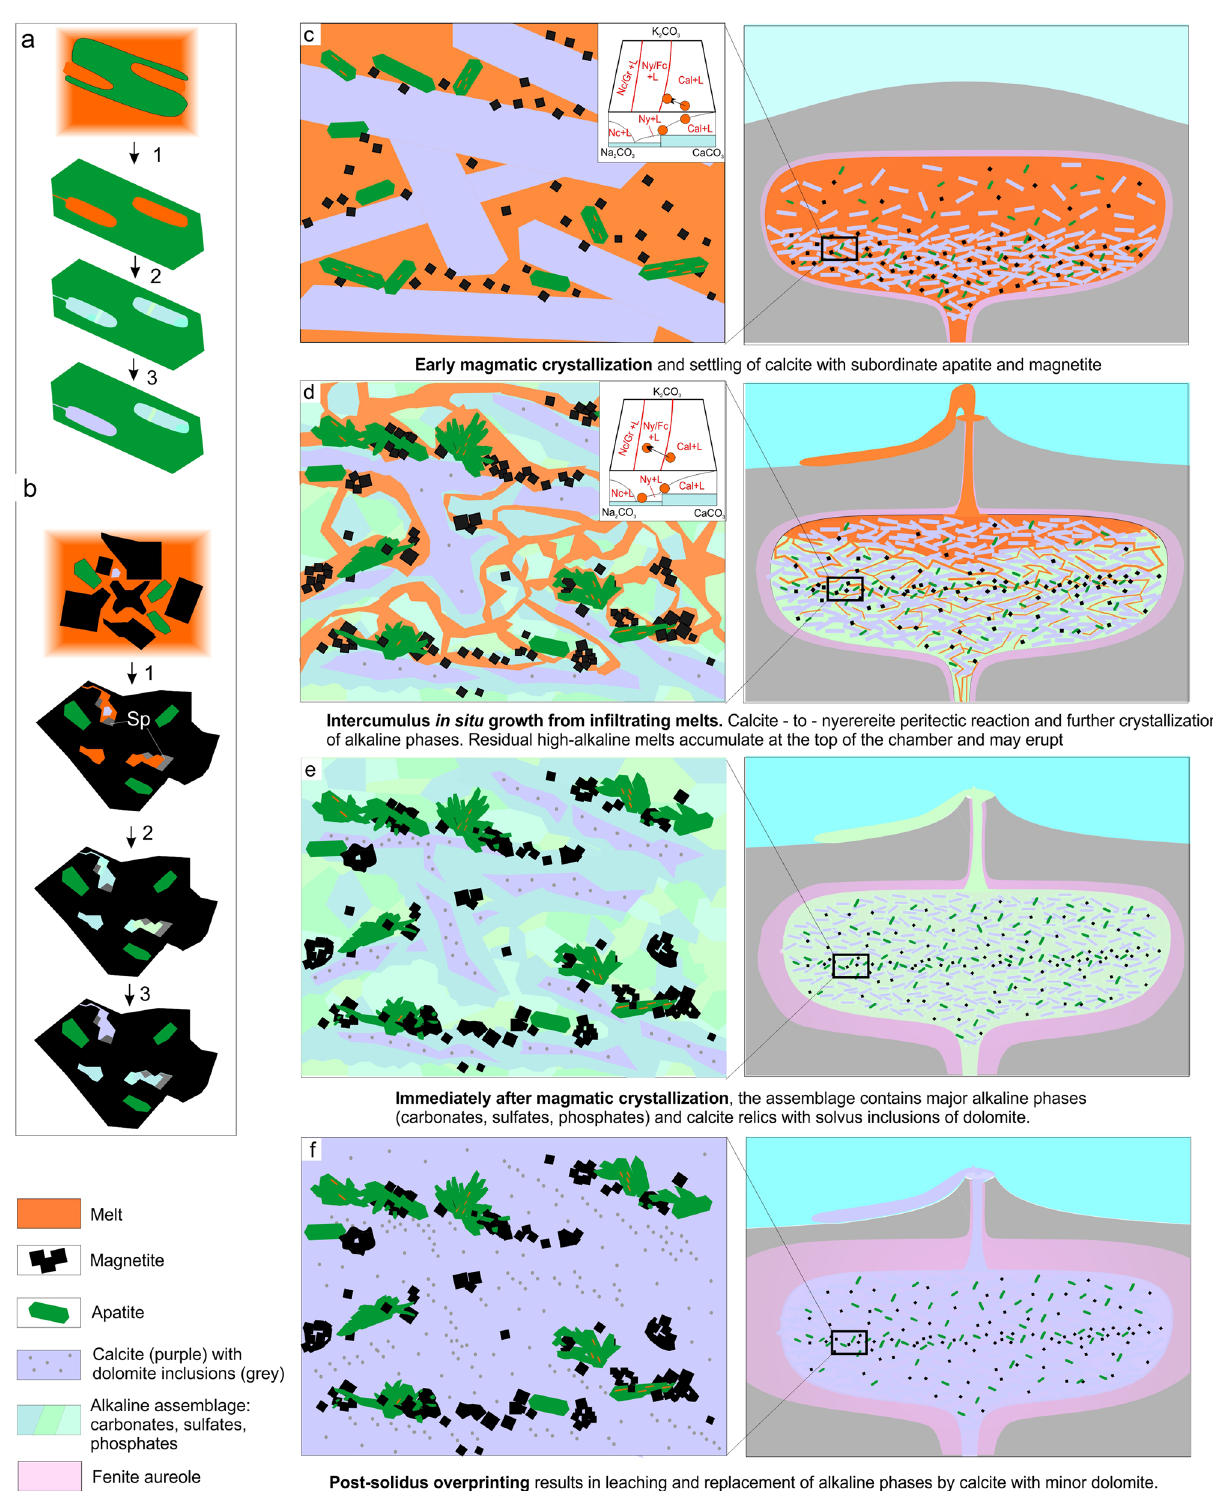
Figure 5. A schematic illustrating the formation of: ( a )—apatite-I-hosted inclusions; ( b )—magnetite-hosted inclusions, and ( c – f )—main stages of the evolution of the magmatic system. ( a , b ) inset numbered stages are: (1) entrapment; (2) crystallization and (3) overprinting. Note that inclusions which were not isolated completely, are subject to leaching and, ultimately, replacement of alkaline assemblages by calcite and dolomite. Corner insets in ( c , d ) show schematic phase diagrams outlining melt evolution paths at given stages (fields outlined from Weidendorfer et al. (2017) 26 The figure was created using Corel Draw X4 software https:// www. corel draw. com/ en/ pages/ corel draw-